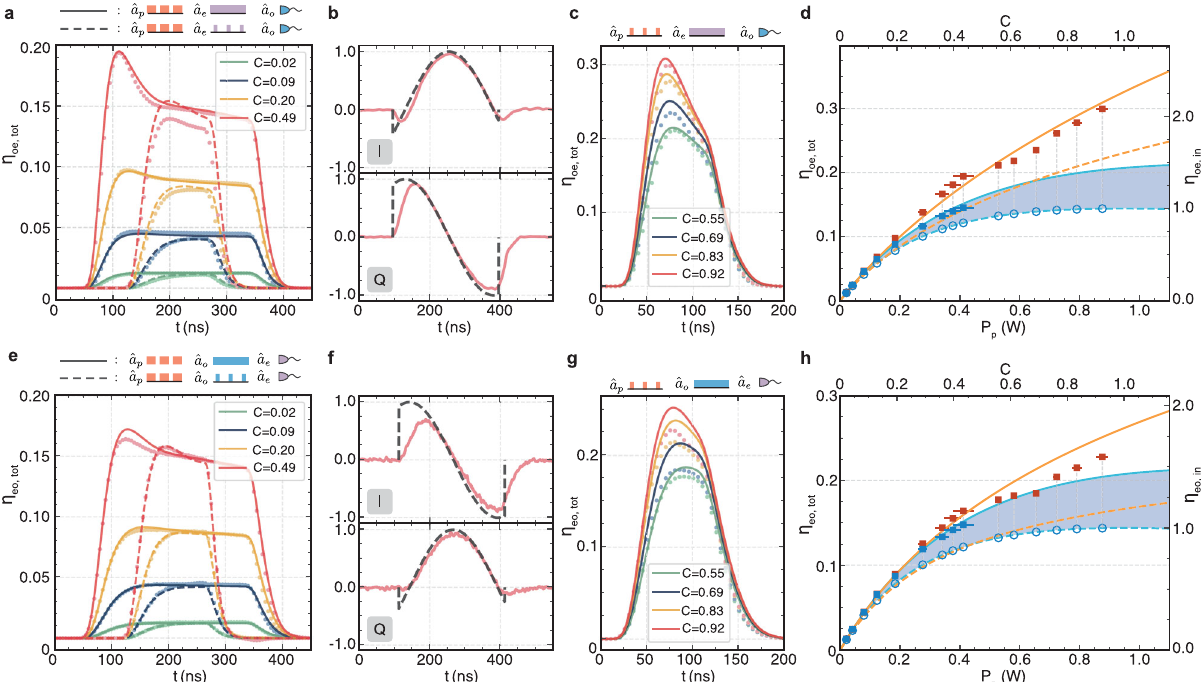
Fig. 2 High cooperativity bidirectional conversion. Top (bottom) row panels show results for microwave-to-optics (optics-to-microwave) conversion. a , e Converted signal pulses (bright dots are calibrated measurements and lines are theory) for a 300 ns-long optical pump pulse measured with a 500 Hz repetition rate for a CW signal (solid lines) and a pulsed signal (dashed lines). b , f Measured IQ quadrature modulation of the converted signal pulse (red lines) and the applied IQ quadrature modulation to the input signal (gray dashed lines) for C = 0.49. c , g Converted signal pulses (bright dots are calibrated measurements and lines are theory) for a 100 ns-long optical pump pulse and a CW signal measured with a 500 Hz repetition rate. d , h Summary of measured steady-state (blue squares) and peak (red squares) total transduction ef fi ciency (left axis) and internal transduction coef fi cient (right axis) as a function of the in-pulse pump power P p and cooperativity. Blue lines show the theoretical prediction for the steady-state (Eq. (2)) and orange lines for the peak values (see Supplementary Information), respectively. Solid lines are theory taking into account the fi nite suppression ratio S ¼ 0 : 22, whereas the dashed lines are for the ideal case S ¼ 0. The blue dashed line indicates the achieved C -dependent steady-state pure conversion ef fi ciency and the blue- shaded area highlights the calculated gain of the measured steady-state transduction ef fi ciency owing to fi nite sideband suppression. The vertical (smaller than the symbols) and horizontal error bars represent the standard error of the individual measured time-averaged